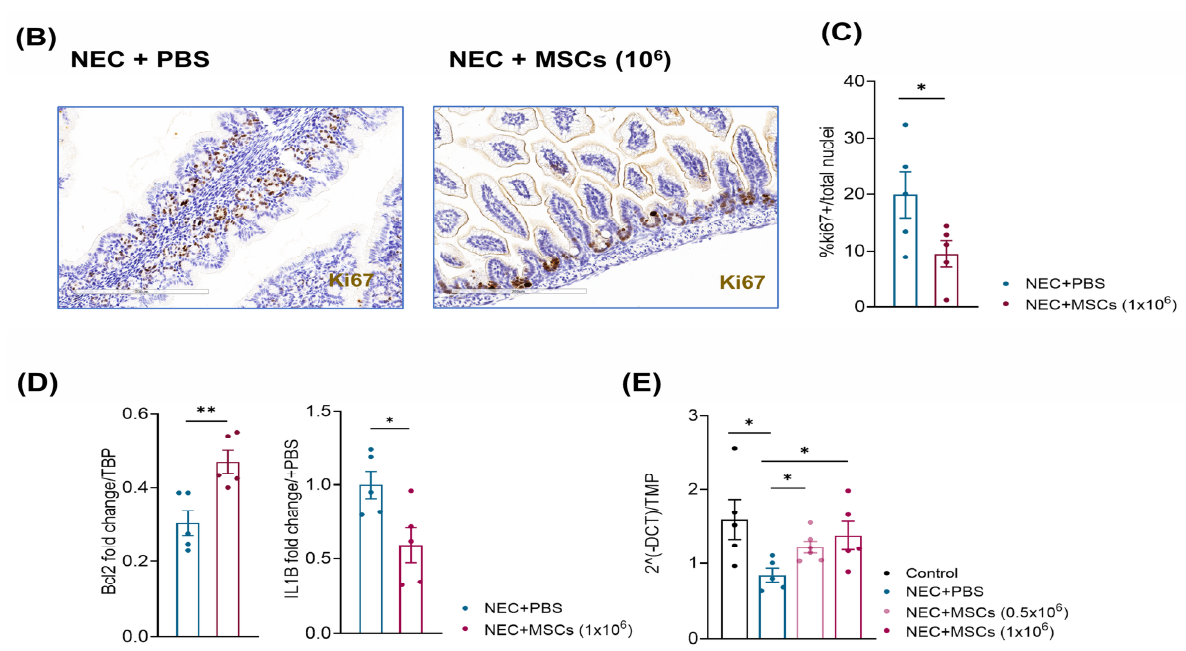
Figure 5. hBM-MSCs reduced apoptosis and stimulated tissue regeneration in a neonatal mouse NEC model. ( A ) Representative Caspase-3 staining on histological intestinal sections from mice belonging to the NEC + PBS and NEC + hBM-MSCs (1 × 10 6 ) experimental groups. Scale bar: 100 μm. ( B , C ) Representative Ki67 staining and its relative quantification on histological intestinal sections from mice belonging to the NEC + PBS and NEC + hBM-MSCs (1 × 10 6 ) experimental groups ( n = 5) Scale bar: 200 μm. ( D ) Relative gene expression of the anti-apoptotic gene Bcl2 and the pro-inflammatory cytokine IL-1B. ( E ) Relative gene expression of the tight junction component ZO-1 in the four indicated experimental groups. Bcl2: B-cell lymphoma 2; hBM-MSCs: human bone marrow-derived mesenchymal stromal cells; IL-1B: Interleukin 1b; NEC: necrotizing enterocolitis; PBS: phosphate-buffered saline; ZO-1: zonula occludens-1. * p < 0.05; ** p < 0.01.